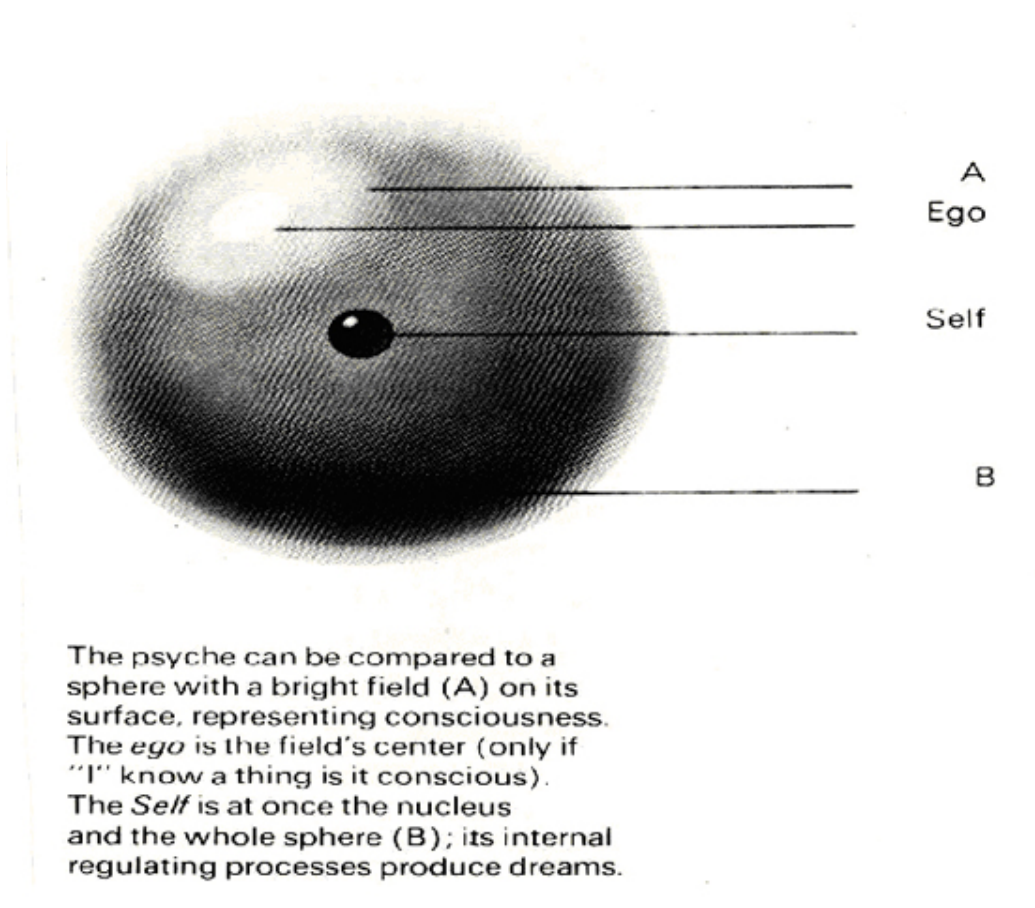
FIGURE 1 . The famous, classical picture by C.G. Jung[4] of the vast human existence with the true self in the middle and the tiny ego on the surface (A), surrounded by a minute, white spot of consciousness, and besides that darkness and unconsciousness (B). The core of existence (the self) is similar to the purpose of life in the life mission